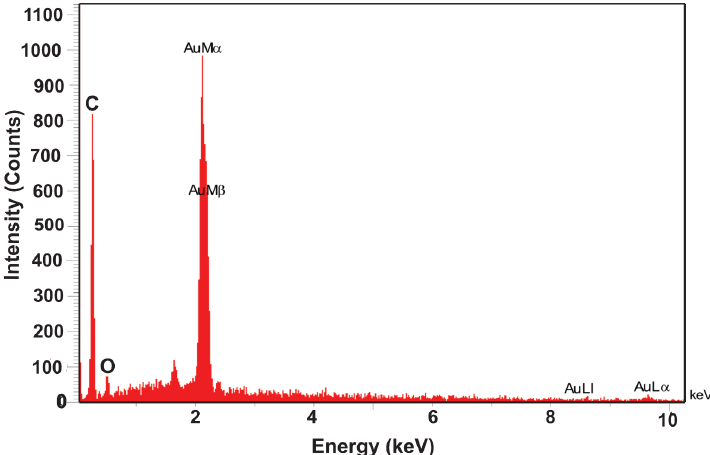
Figure 3. The EDX analysis of CC-AuNPs synthesized by C. caspius extract. The hydrodynamic diameter of synthesized CC-AuNPs was assessed using DLS analysis, indicating the mean size of 101.4 ± 19.6 nm by number (Figure 4a,b). DLS analysis for gold nanoparticles synthesized by Moringa oleifera petals displayed an average hydro- dynamic size of 203 nm [34]. In another study, the DLS analysis of AuNPs prepared using Scutellaria barbata yielded an average size of 154 nm [2]. It is to be expected that the particle size determined by TEM and DLS scattering differs slightly due to the differing measure- ment methods [34]. The stability of nanoparticles was determined by zeta potential that was determined as − 30.8 ± 1.5 mV for the prepared CC-AuNPs. The phytochemicals, act- ing as capping agents, can produce repulsive forces on the surface of nanoparticles that make them stable [35]. Figure 4. ( a ) Hydrodynamic particle size of CC-AuNPs using DLS (number-weighted) analysis (101.4 ± 19.6 nm), ( b ) zeta potential analysis of CC-AuNPs ( − 30.8 ± 1.5). The FT-IR analysis was carried out to demonstrate the presence of the functional group and biomolecules in C. caspius extract. The roles of the extract as a reducer and a stabilizer stem from the availability of these groups. The FT-IR spectrum of the CC-extract and extract-mediated AuNPs (CC-AuNPs) is depicted in Figure 5. The peaks at 3285 cm − 1 confirm the presence of the stretching vibration of phenolic hydroxyl [35,36]. The role of phenols as free radical scavengers has been clarified in recent years [23]. The peaks located at 2924 and 2854 cm − 1 are associated with saturated hydrocarbons (Csp 3 –H) [37]. Recently, it has been mentioned that the appearance of hydroxyl and carboxyl ions attests to the fact that the biomolecule could form the protective layers to stabilize the metal NPs [38]. The peak region of 2112 cm − 1 was associated with stretching bands of the -C C- [4], 1624 cm − 1 peak (stretching band of the carboxyl coupled to the amide I band) [39], 1708 cm − 1 for